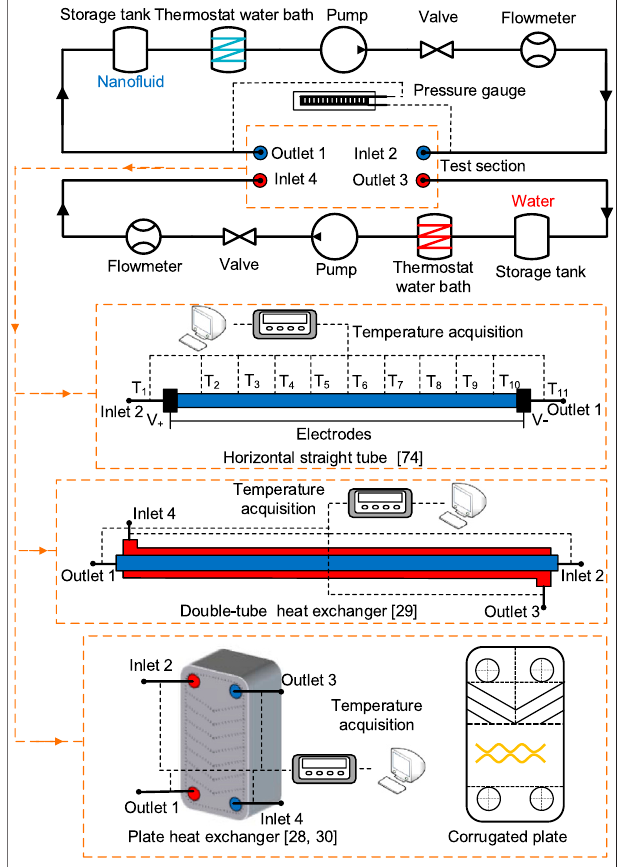
FIGURE 7 | Schematic diagram of experimental systems of forced convection